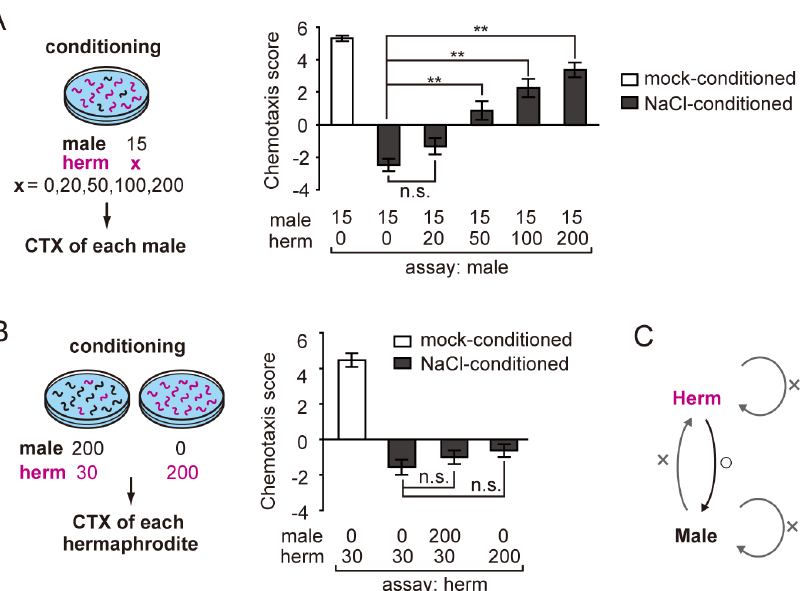
Figure 2. Hermaphrodite density is critical for sexual conditioning. (A) The dependency of sexual conditioning on the number of hermaphrodites present during conditioning. Salt attraction of males increases with increasing density of hermaphrodites during conditioning. CTX, chemotaxis. (B) The plasticity of salt chemotaxis in hermaphrodites is not significantly affected by the presence of males or hermaphrodites during salt/starvation conditioning. (C) Summary of inter-individual interactions that lead to suppression of salt aversion in males and hermaphrodites. **, P , 0.001; n.s., not significant. Error bars represent SEM. n=49–80 animals for each condition.